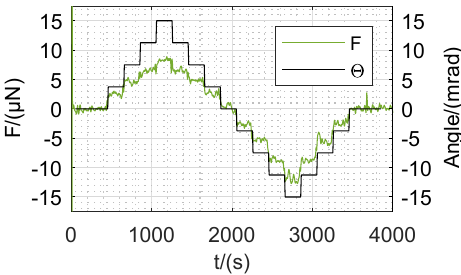
Figure 13. Measured force during tilt about the y axis ( (cid:50) ).